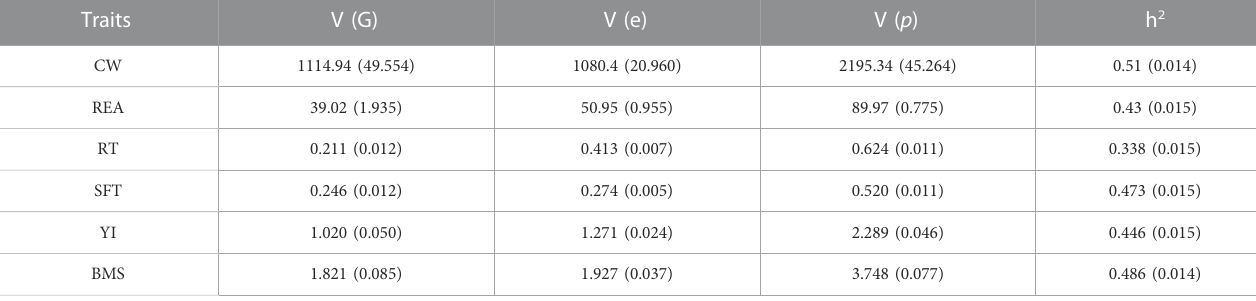
TABLE 2 Heritabilities, and variance components calculated from bivariate analysis of six carcass traits of Japanese Black cattle.